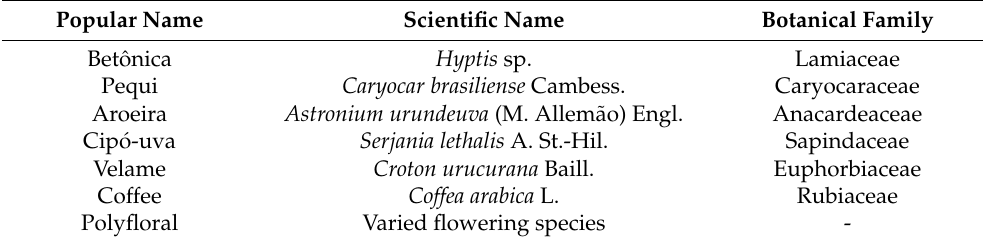
Table 2. Identification of honeys of the according to predominant